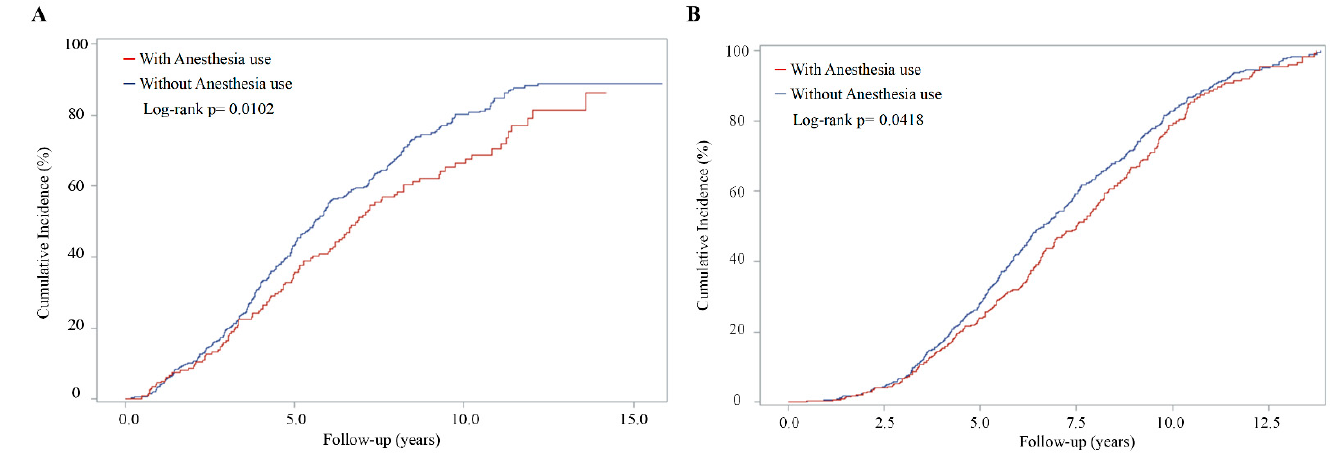
Figure 2. Kaplan–Meier plot of the cumulative incidence of asthmatic patients following general anesthesia (GA) exposure. It is showed that patients with GA exposure (red line) were associated with favorable clinical visits with asthma than the non-GA exposure group (blue line), regardless of whether their asthma onset was ( A ) before GA ( p = 0.0102) or ( B ) after GA exposure ( p = 0.0418).